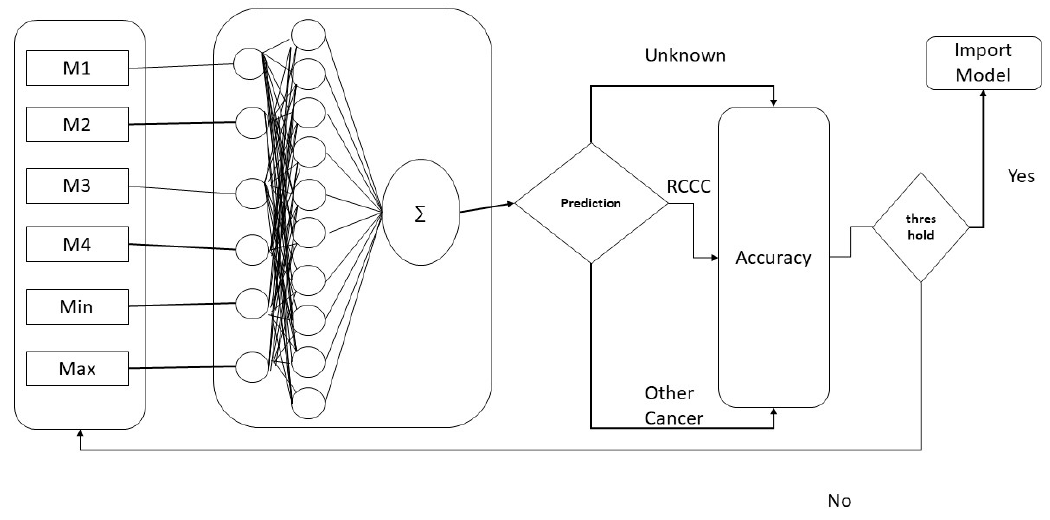
Figure 2. Architecture of the ANN model.